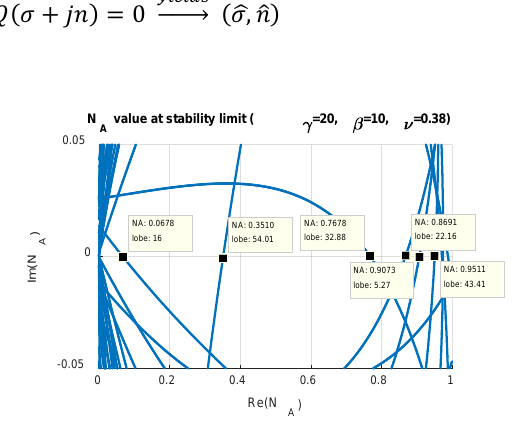
Fig. 6. NA at stability limit for the considered example